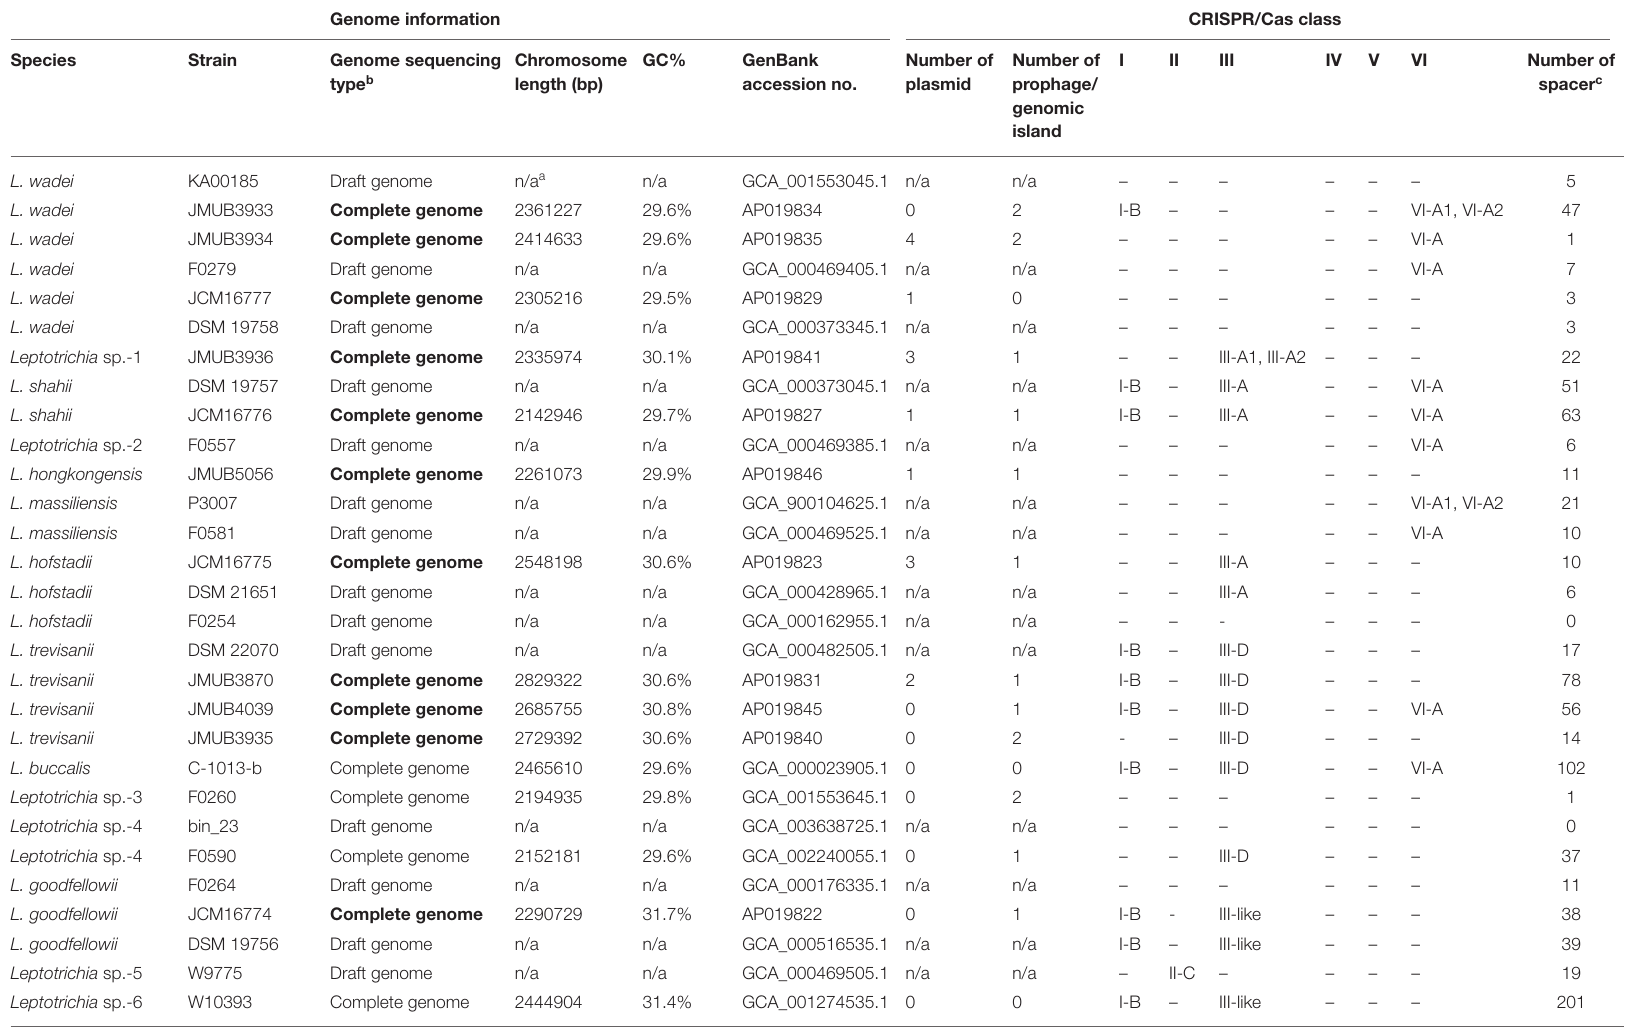
TABLE 1 | Genome and CRISPR-Cas system information of genus Leptotrichia